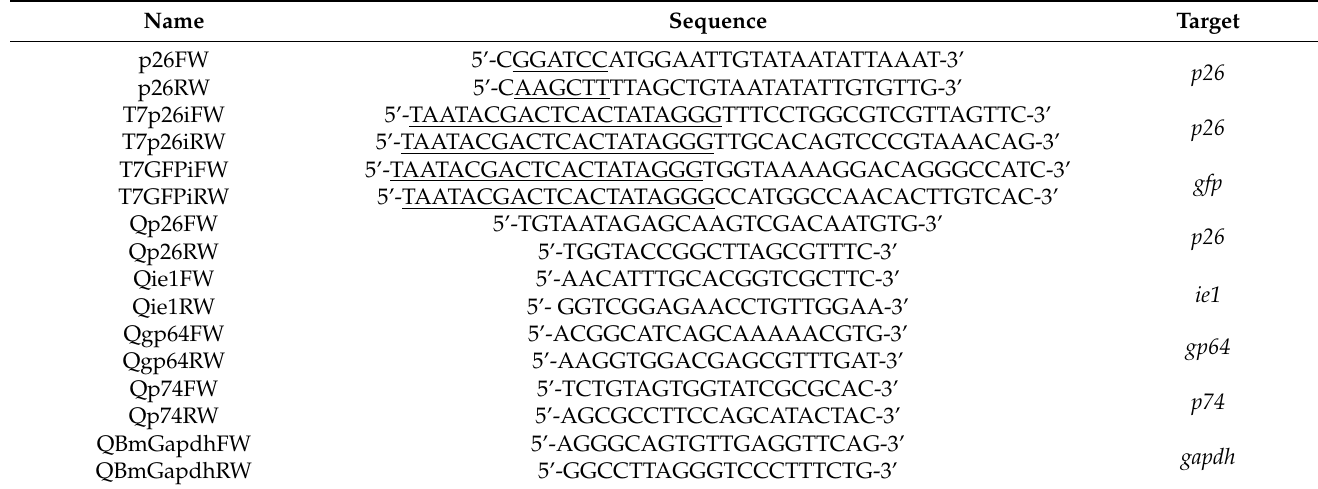
Table 1. Primers used in this